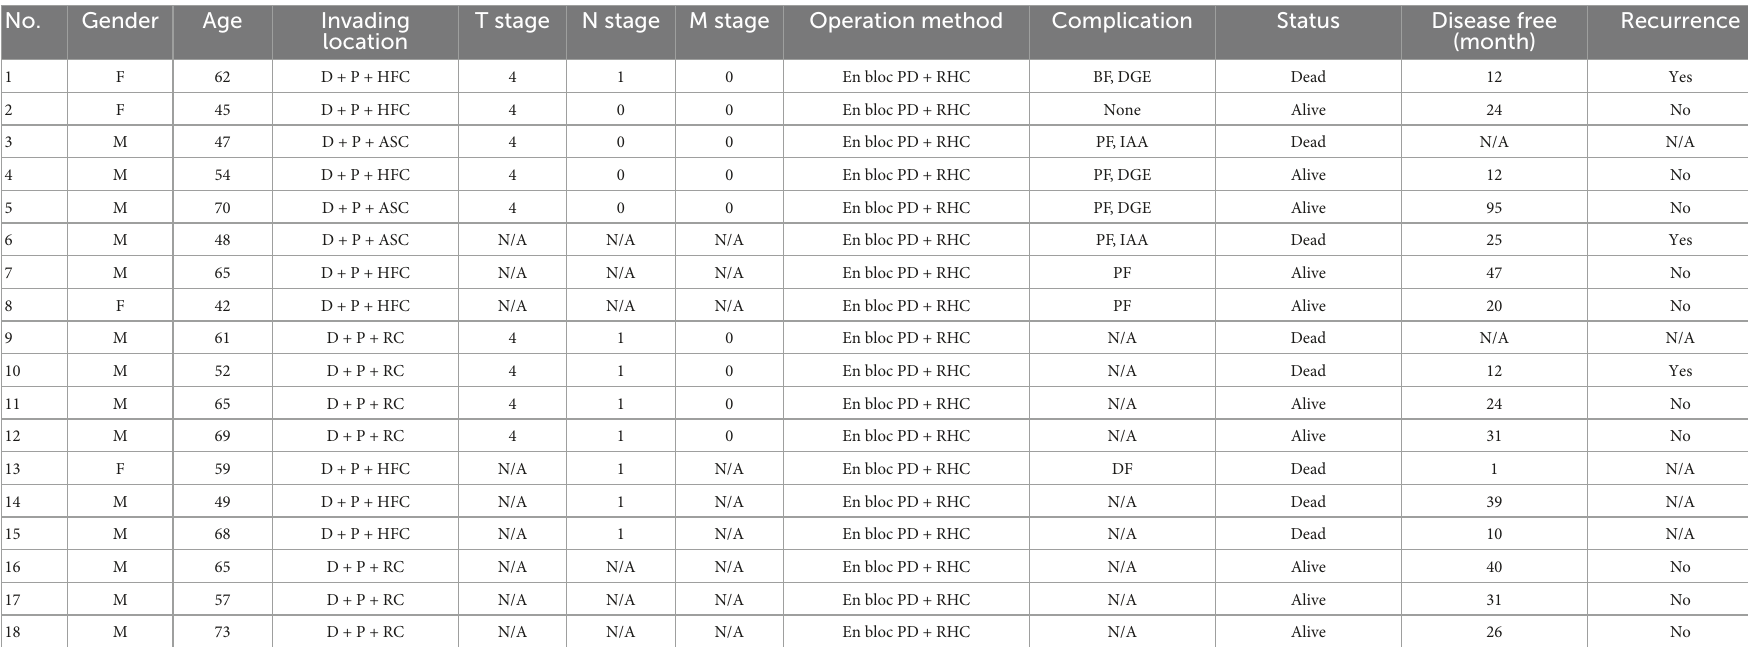
TABLE 4 The comparison of local pancreaticoduodenectomy and en bloc PD resection with RHC when right colon cancer (RCC) invaded pancreas and duodenum.